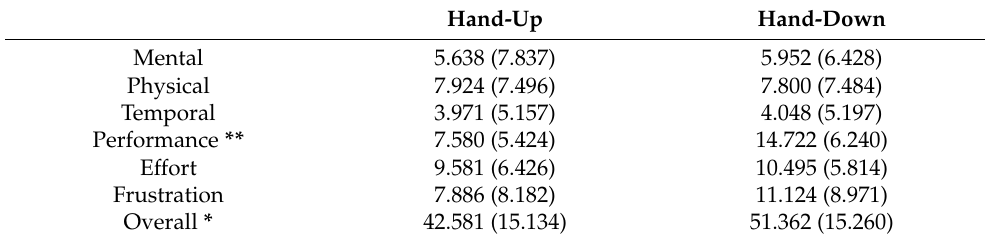
Table 2. The average and standard deviation of all subjective workload scores on postures.